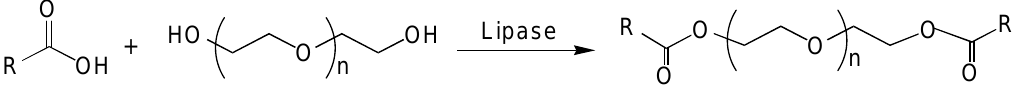
Figure 20. Lipase-catalyzed synthesis of PEG